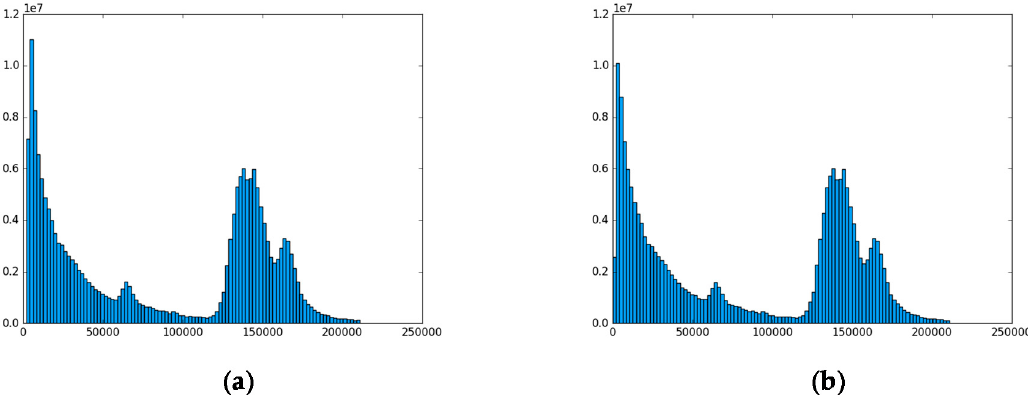
Figure 8. The distribution of point distances in the Aerosol dataset. ( a ) The histogram calculated with all 450 dimensions. ( b ) The histogram calculated with the selected 36 dimensions. The two are almost identical, implying that dimension reduction will not affect the result.